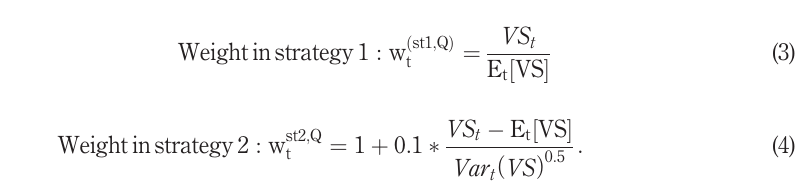
Figure 5. Time-series of standardized value spread and return on value